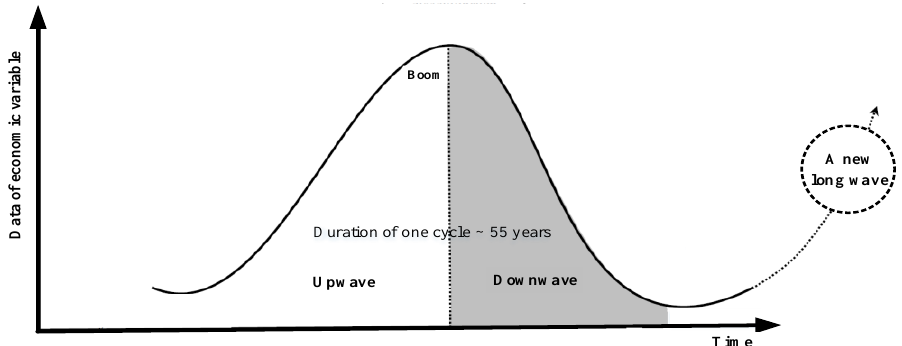
Fig. 3. Evolution of Kondratieff waves